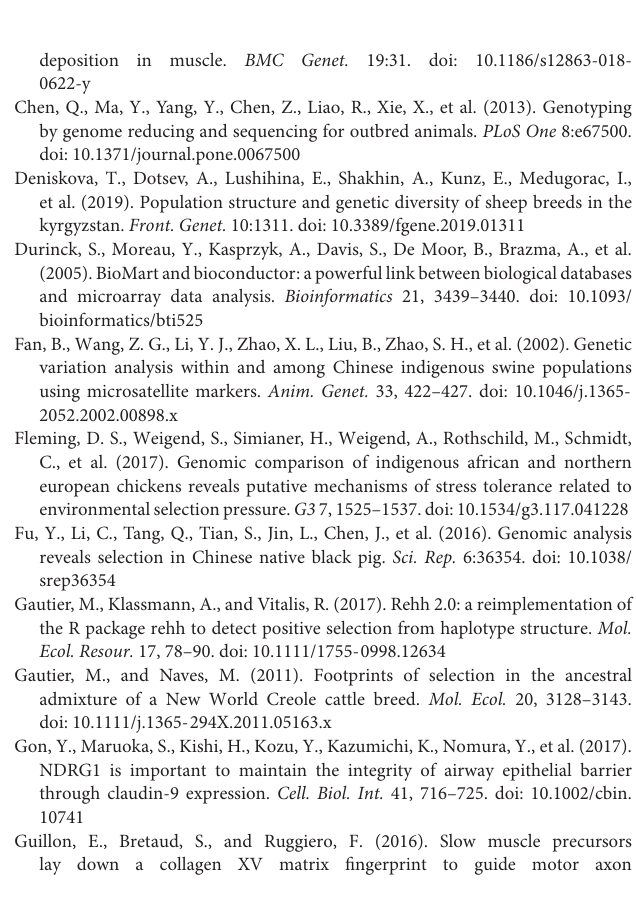
FIGURE S1 | Distribution of the SNPs on the chromosomes. The x -axis denotes the chromosomal position (Mb), and the y -axis represents the chromosomes. The number of the SNPs present in each 400 kb genome block is expressed via colors. TABLE S1 | The associated genes within ROH